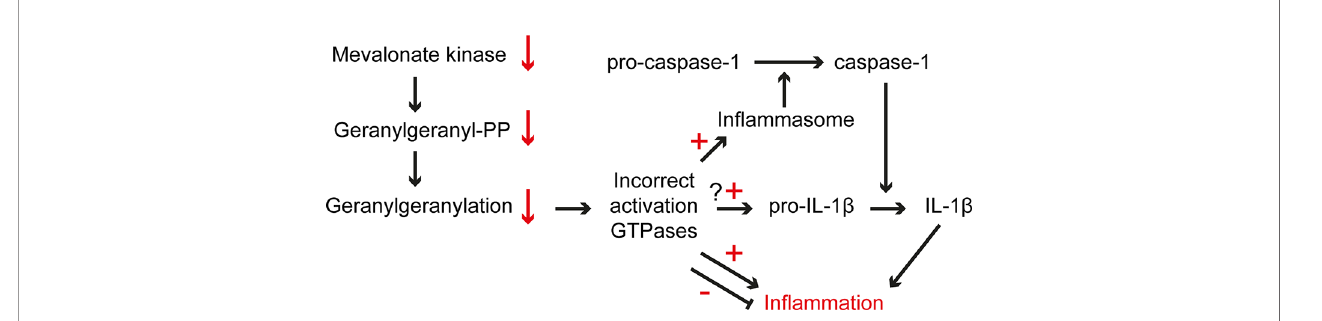
FIGURE 3 | Pathogenic mechanisms in MKD. The low residual MK activity in MKD cells is sensitive to increased temperatures, which causes an instant further lowering of the activity and consequently a decreased fl ux in isoprenoid biosynthesis, which affects the generation of GGPP. The lack of GGPP affects protein geranylgeranylation resulting in ectopic activation of small GTPase, among which GTPases involved in the regulation of the innate immune response. This may cause uncontrolled activation and/or dampening of an in fl